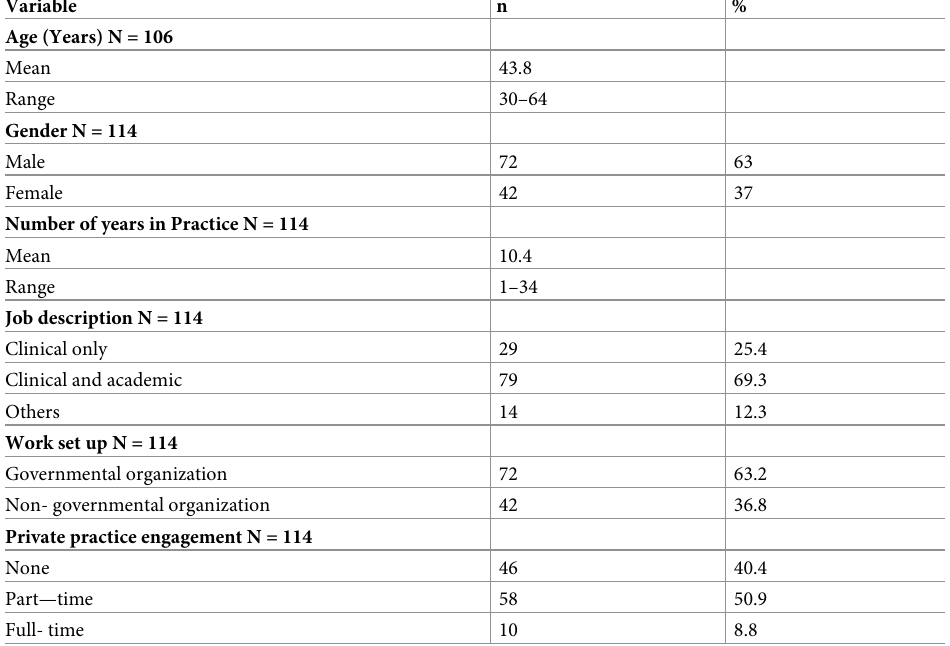
Table 3. Socio-demographic description.